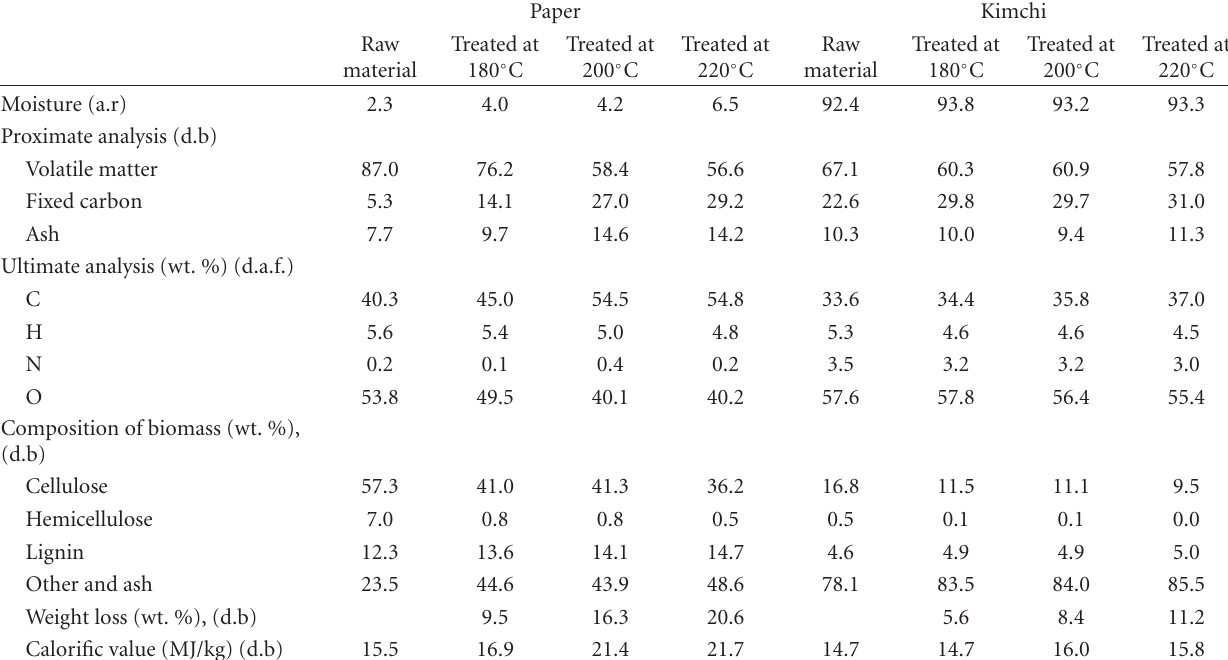
Table 2: Proximate and ultimate analysis results of paper and kimchi and their products.